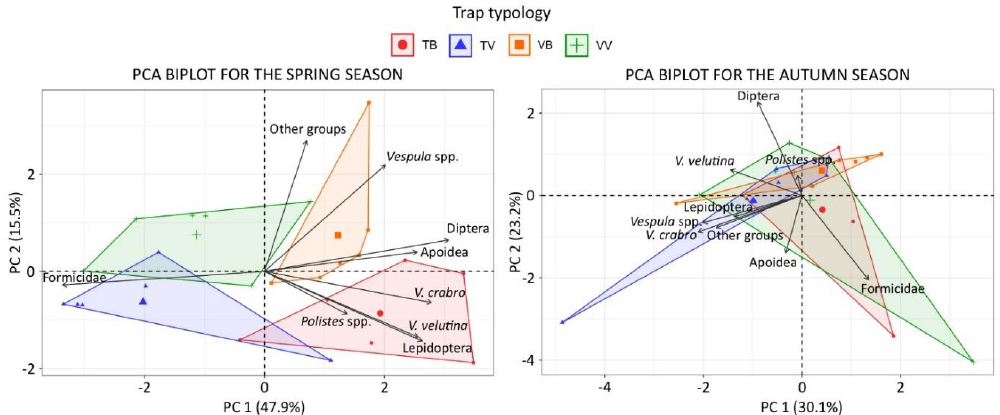
Figure 4. PCA biplot of individuals and variables for the spring ( left ) and autumn ( right ) season. Convex hull polygons highlight individuals of each trap–bait combination.